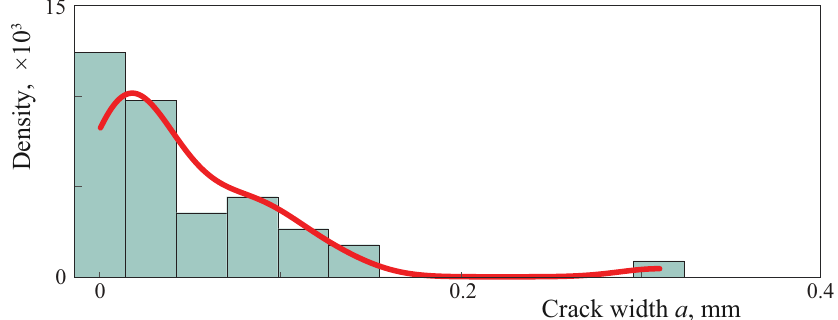
Figure 8. A typical example of histogram and the empirical density function of generated crack width distributions a in bridged zones ( b = 20 mm, ∆ b = 10 mm, η = 10 − 4 ) for hyperbolic law.